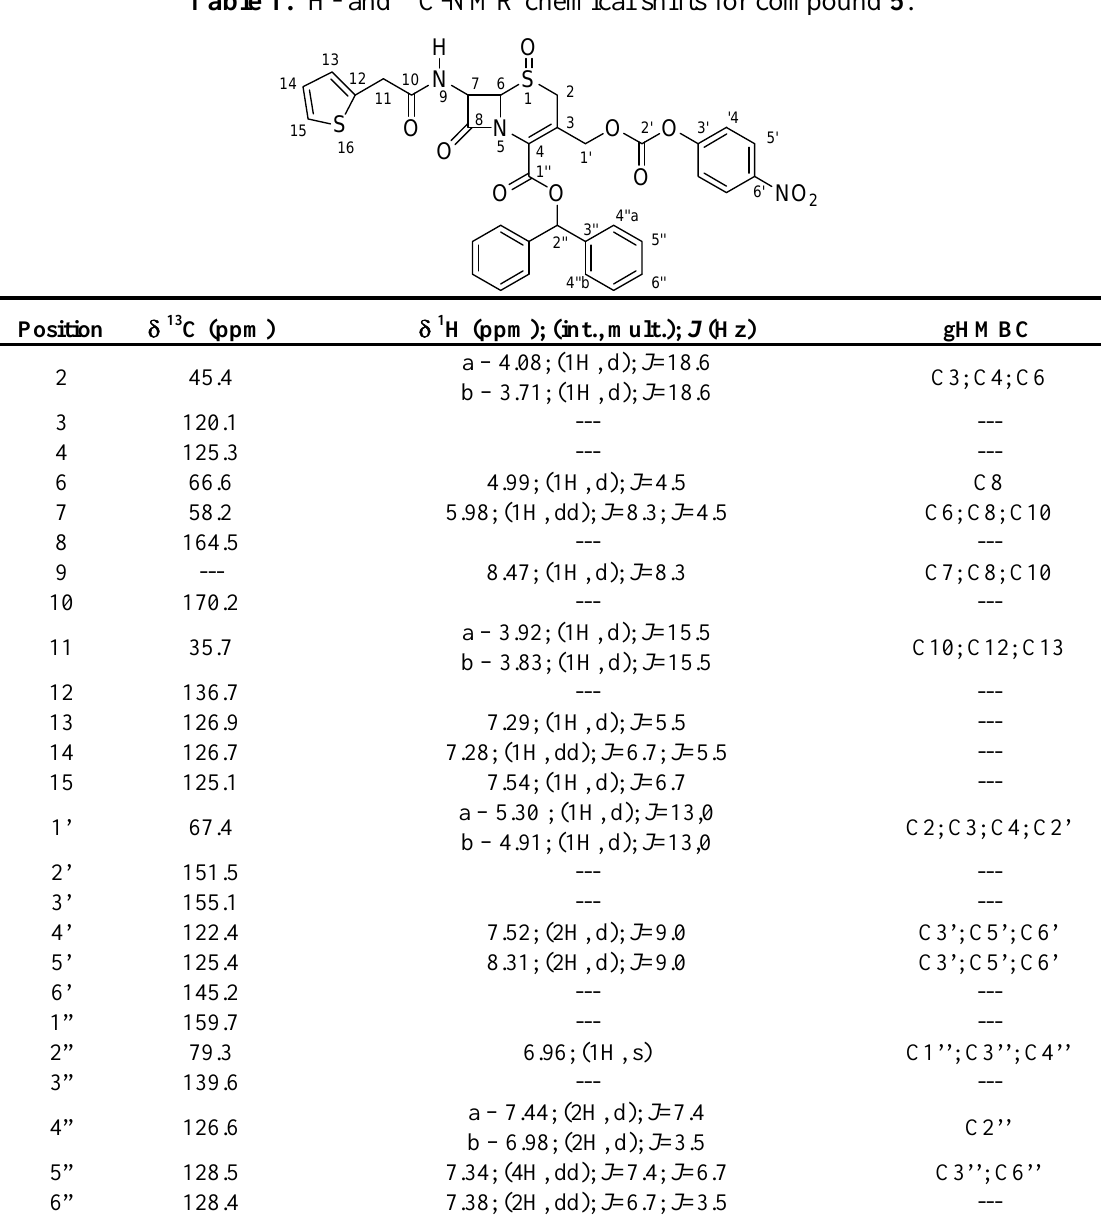
Table 1. 1 H- and 13 C-NMR chemical shifts for compound 5